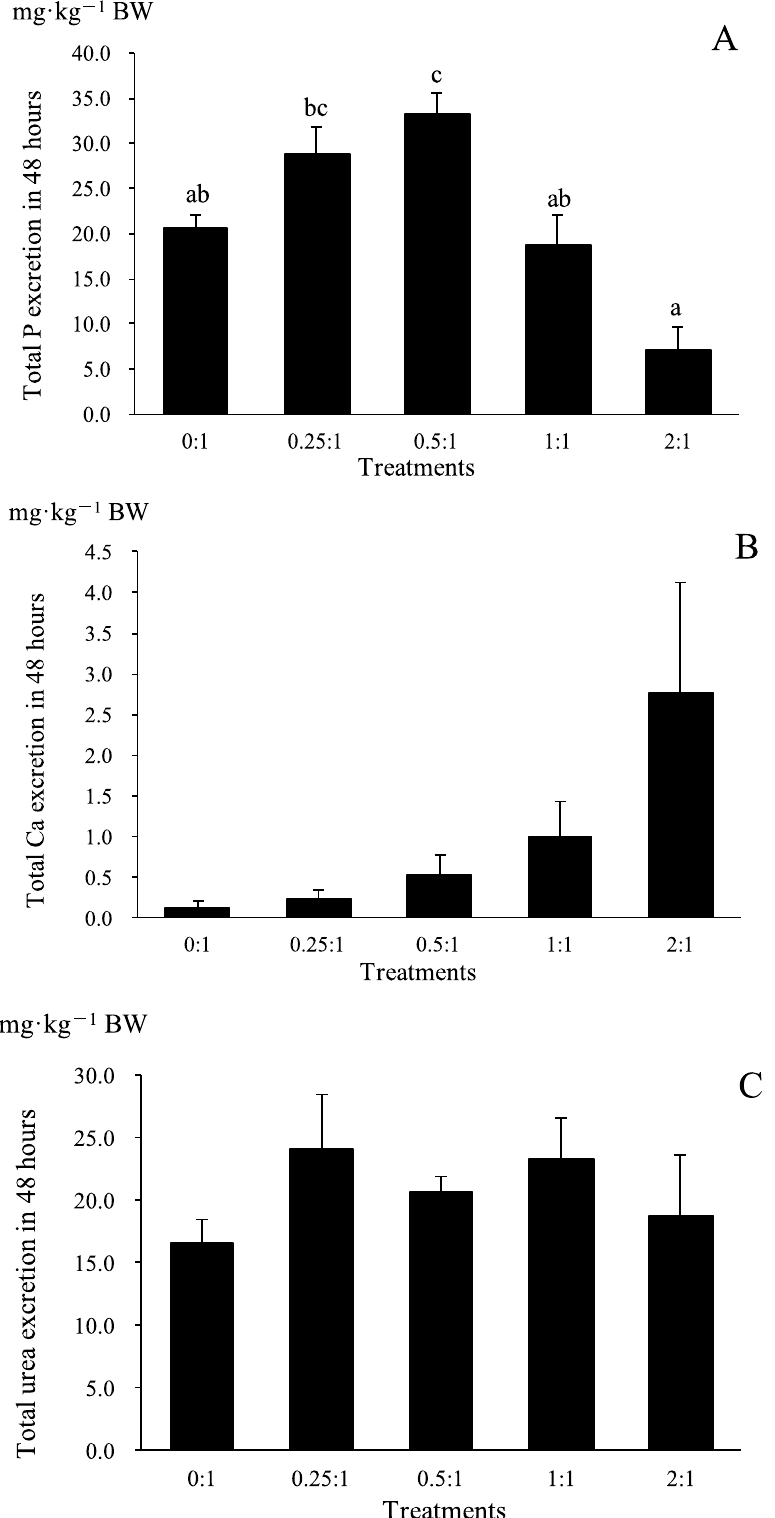
Figure 5. Total excretion amount of P ( A ), Ca ( B ), and urea ( C ) by hybrid sturgeon ( Huso dauricus ♀ X Acipenser schrenckii ♂ ) in 48 h after being intubated with 100 mg P·kg − 1 BW at different Ca/P ratios. Different letters indicate significant differences among the treatments ( p < 0.05).